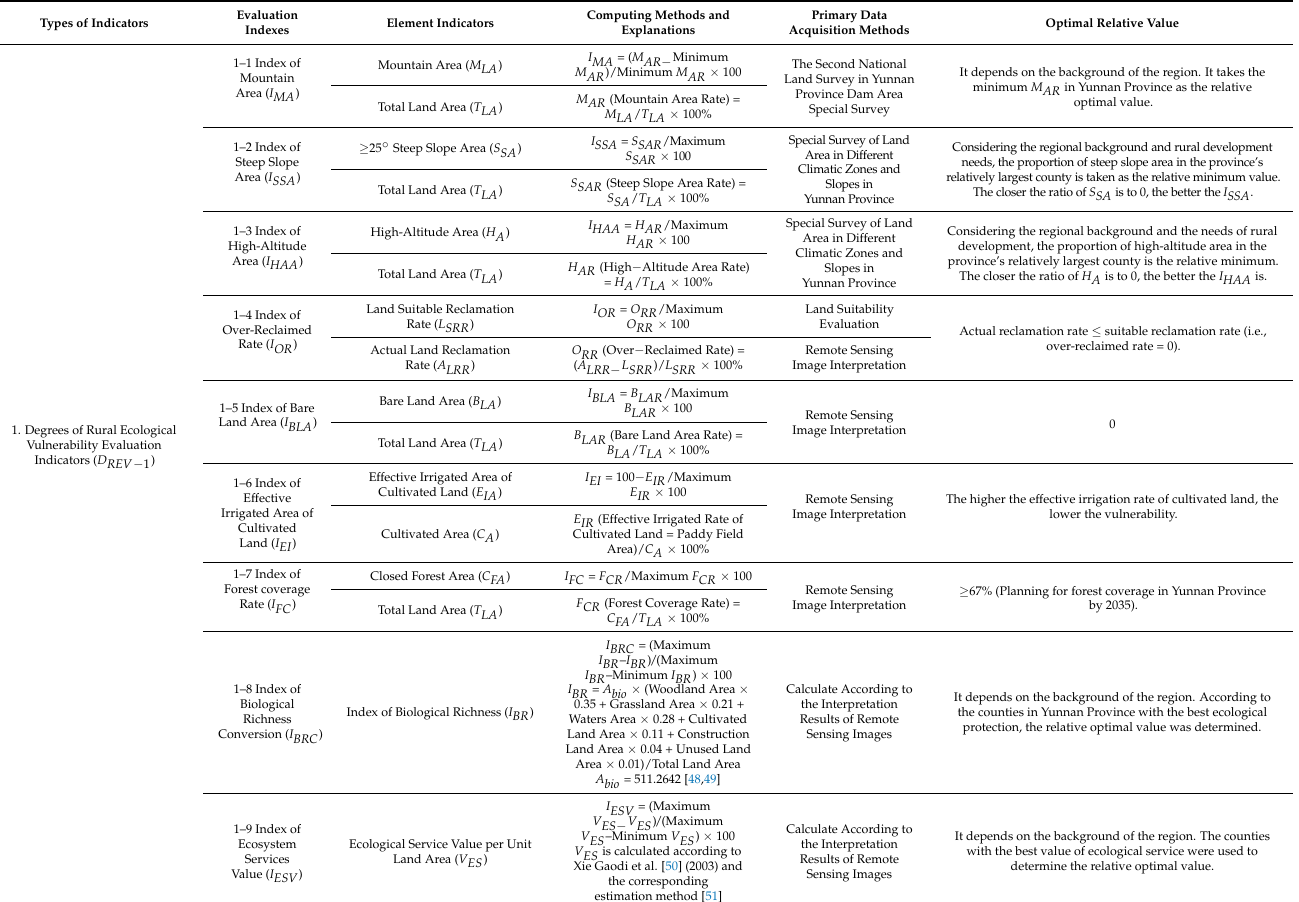
Table 2. Rural Vulnerability in Yunnan: Evaluation Indicator System, Computing Approaches, Data Acquisition Techniques, and Evaluation